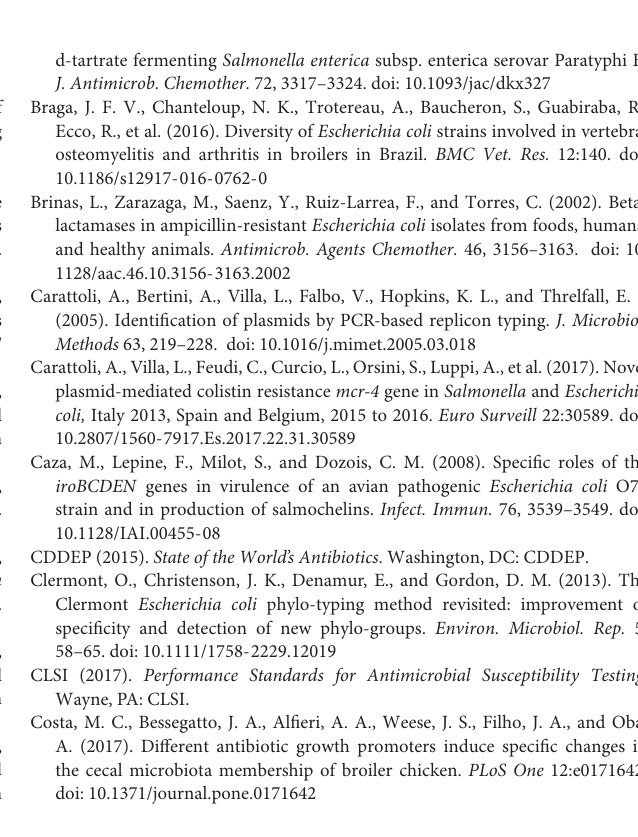
Supplementary Table 4B | Statistical analysis based on site of isolation. Supplementary Table 4C | Prevalence analysis based on site of isolation. Supplementary Table 4D | All